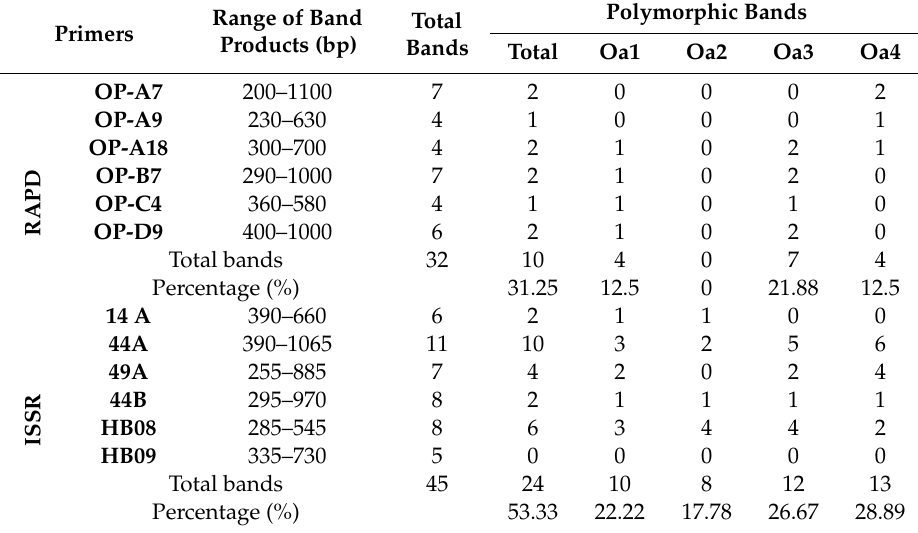
Table 3. The range of band products, and the number of common and polymorphic bands produced by di ff erent primers for Onopordum alexandrinum populations generated by six primers. 1 = Oa1 (sand dunes), 2 = Oa2 (abandoned fields), 3 = Oa3 (barley fields), 4 = Oa4 (desert plateau).